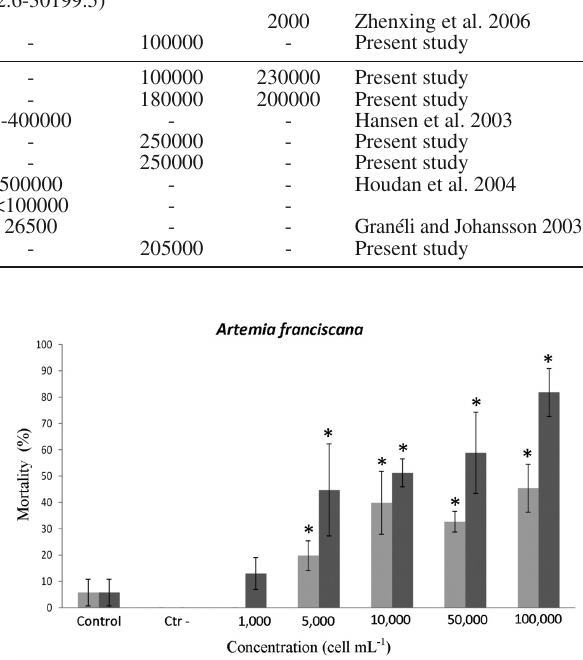
Fig. 4. – Mortality after 24 h (dark grey bar) and 48 h (light grey bar) of nauplii larvae of Artemia franciscana exposed to Alexandrium minutum culture. Two controls were used: standard seawater (0.22 µm) and Isochrysis galbana as a negative control. * significant dif- ferences